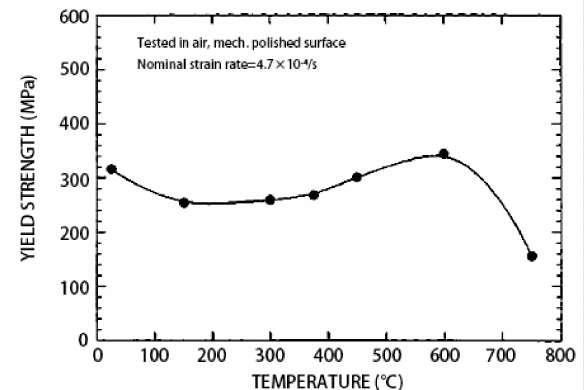
Figure 21. Variation in yield strength with temperature for Fe-40Al-0.6C alloy, determined under a strain rate of 4.7 × 10 − 4 s − 1 . Reprinted with permission from ref. [12]. Copyright 1998